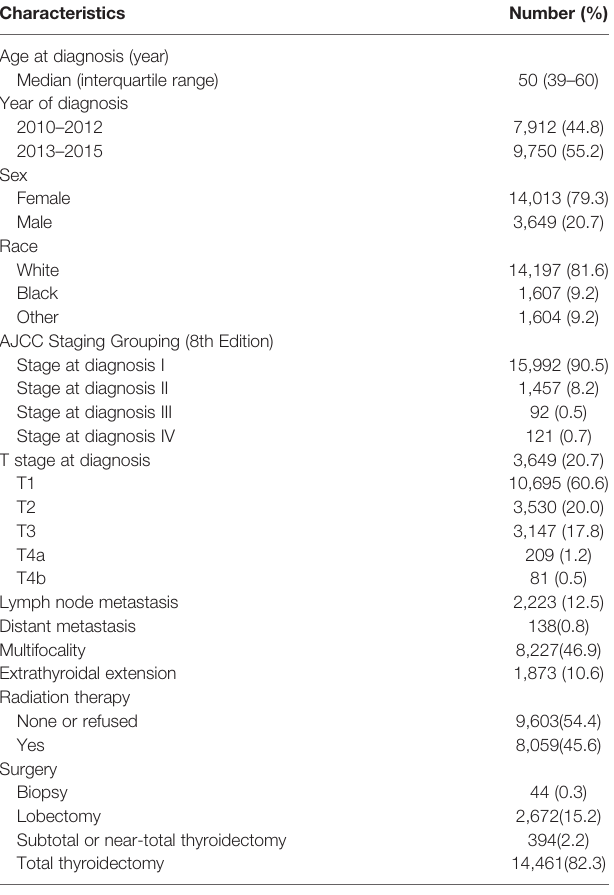
TABLE 1 | Demographic and clinicopathological characteristics of 17662 patients with FVPTC.